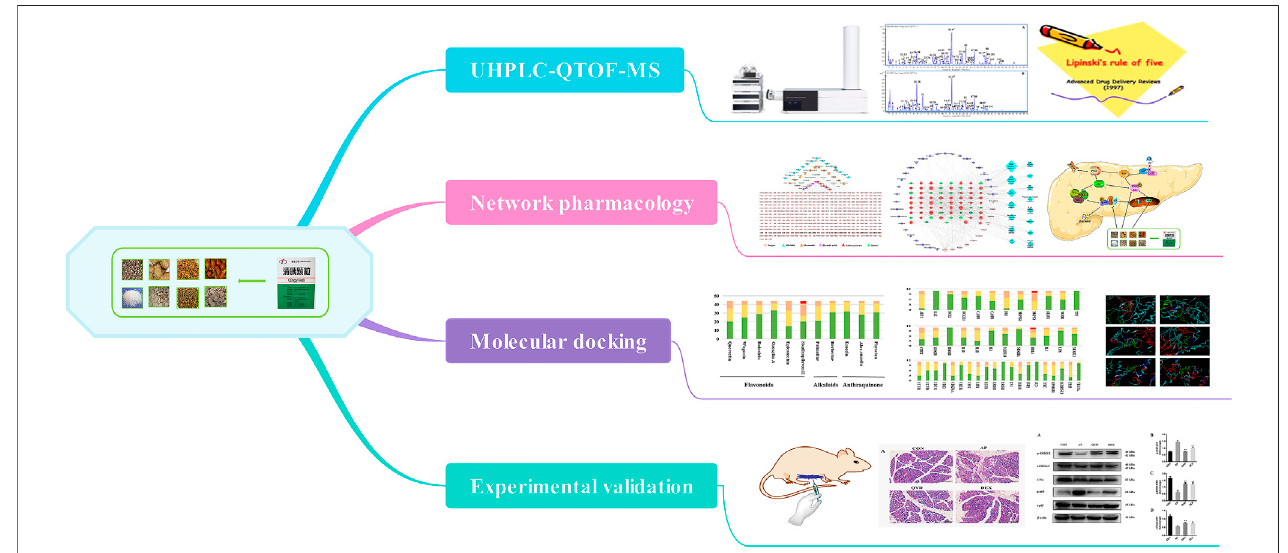
FIGURE 1 | The schematic diagram of the present